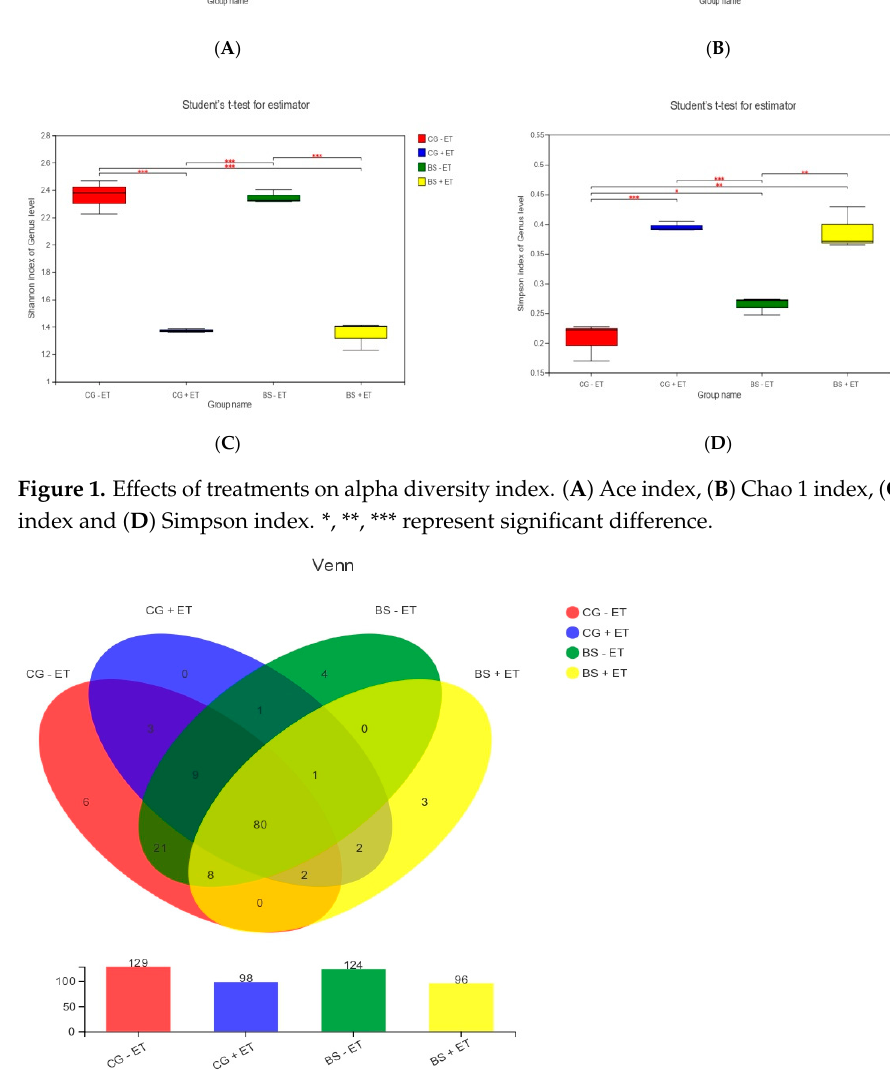
Figure 2. Present Venn diagram shows the all, unique and overlapped OTUs observed in/between treatments.